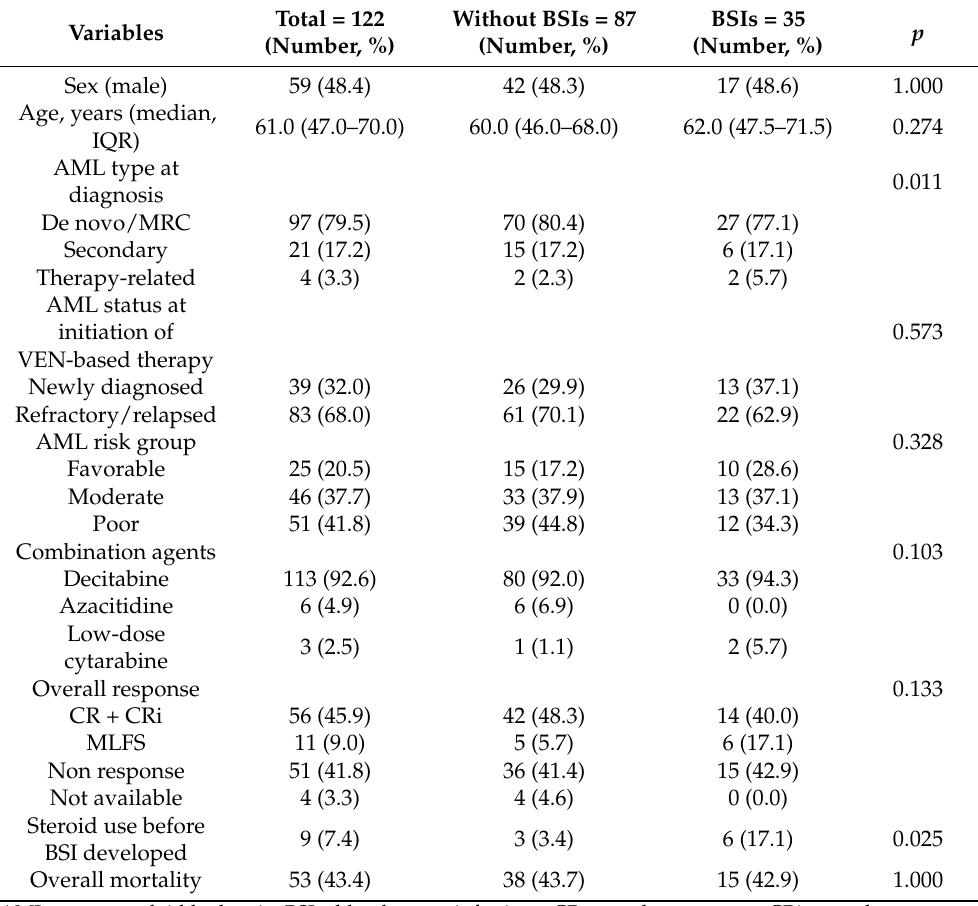
Table 4. Characteristics in patients according to bloodstream